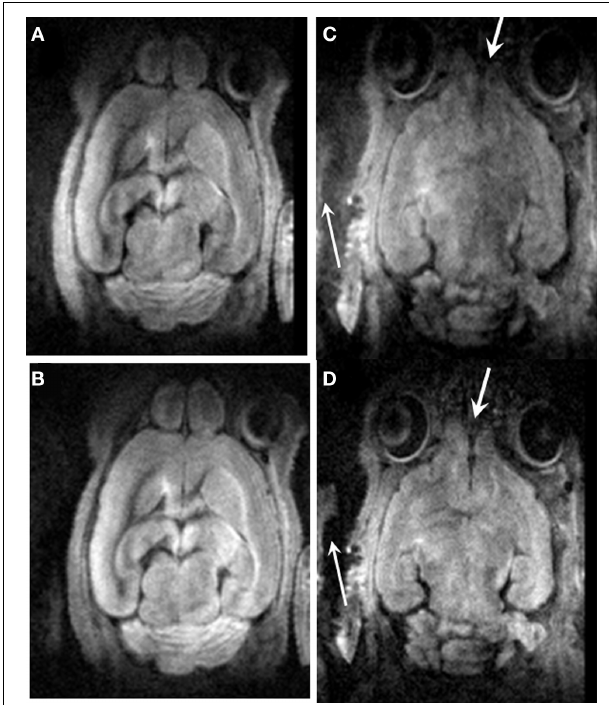
FIGURE 3 |The comparison before and after twin navigator echo correction. (A) A slice of the dorsal side before (A) and after (B) correction; (C) a slice of the ventral side before (C) and after (D) correction. Motion artifacts were minimized after the twin navigator echo correction as marked by the arrow.